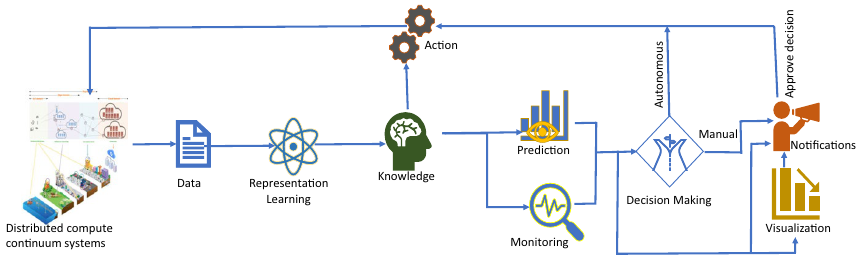
Fig. 3 The proposed governance and sustainability conceptual framework for